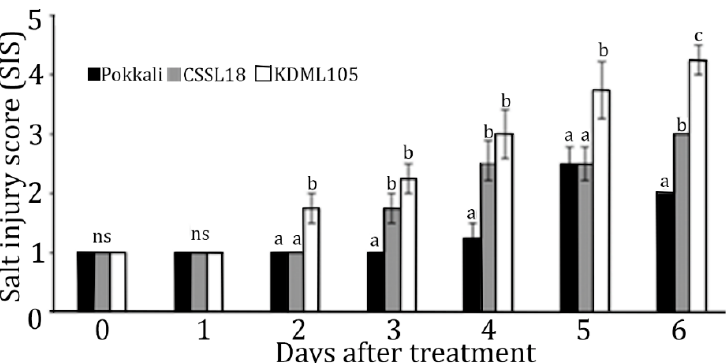
Figure 4. Salt injury scores for CSSL18, ‘KDML105’, and ‘Pokkali’ rice seedlings treated with 75 mM NaCl as a check for the transcriptomic study of CSSL18 and ‘KDML105’. The di ff erent lower case letters show the significant di ff erence of means, p < 0.05.